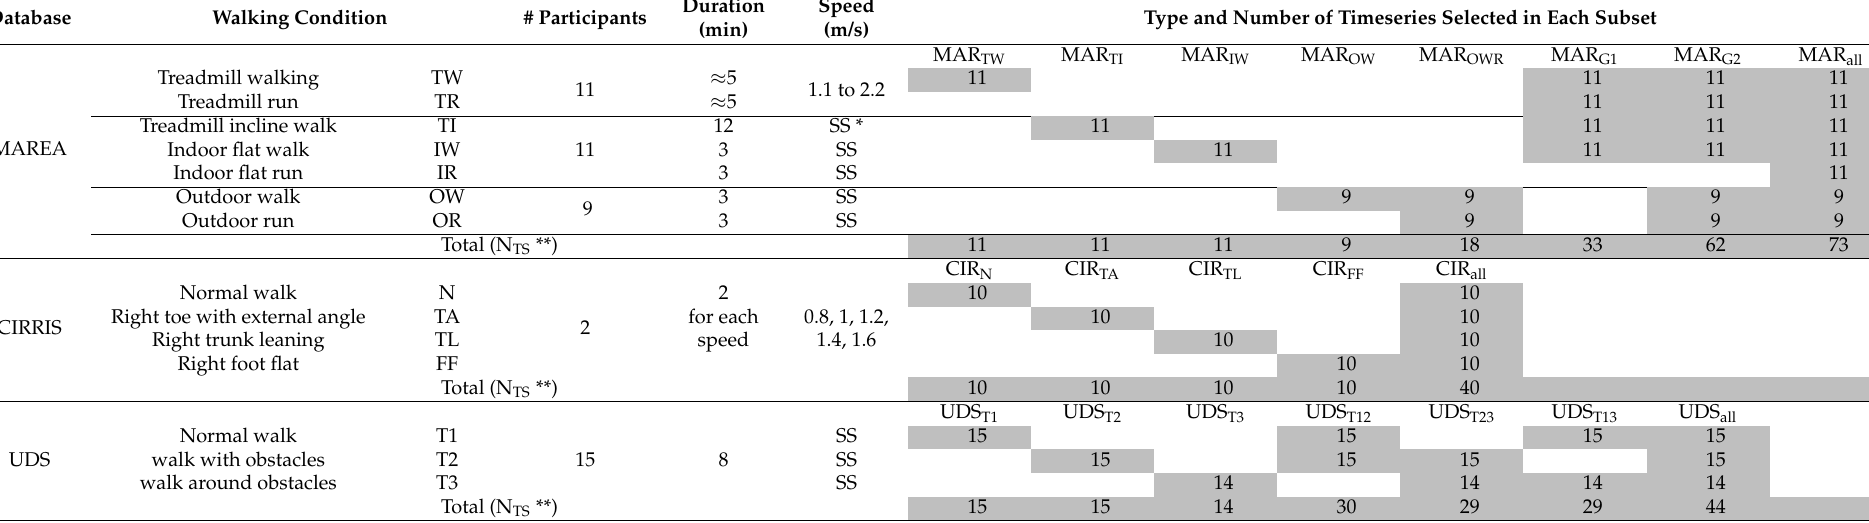
Table 1. Database